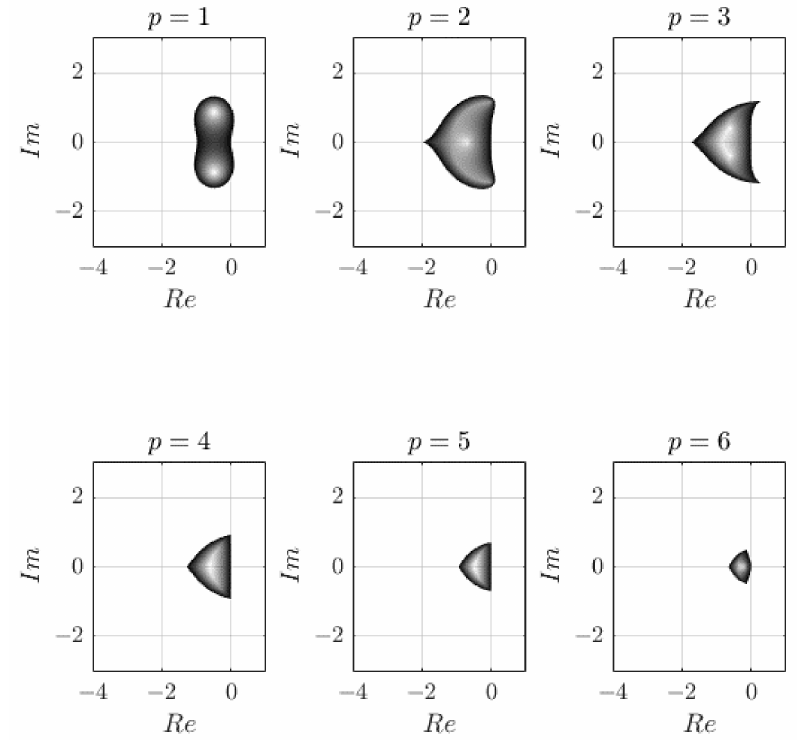
Figure 5. Stability regions of Adams–Bashforth–Moulton